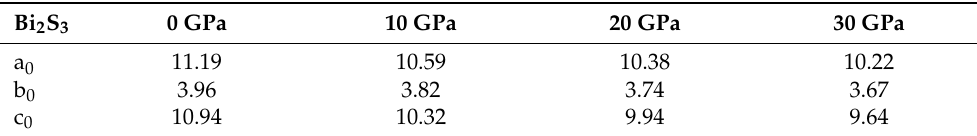
Table A2. Theoretical estimation (PBEsol) of the lattice parameters of the Bi 2 S 3 compound, for the Pnma structural phase, for different pressure values, at which the system is both energetically and dynamically stable (presented in units of Å).